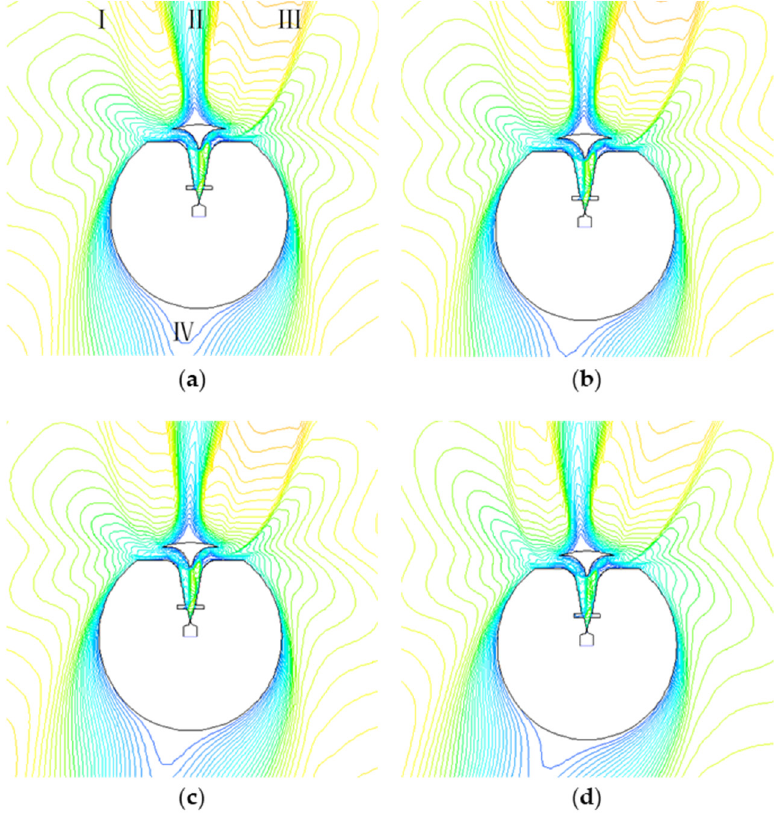
Figure 13. Mach number contours of the whole flow field at different rotational angular velocities: ( a ) 0 r/s, ( b ) 10 r/s, ( c ) 20 r/s, ( d ) 50